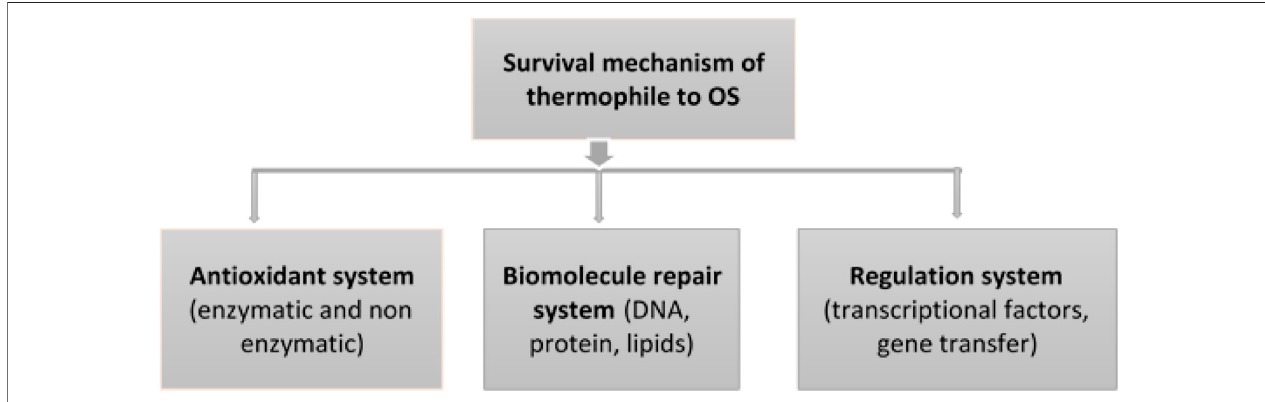
FIGURE 4 | Response mechanisms of thermophiles and their regulation system to adapt oxidative